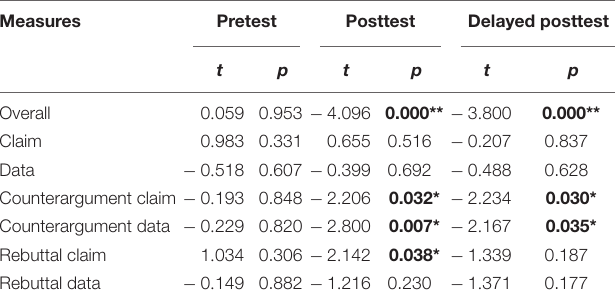
TABLE 3 | Between-subject comparisons of holistic and analytic scores on quality of argument across tests. Measures Pretest